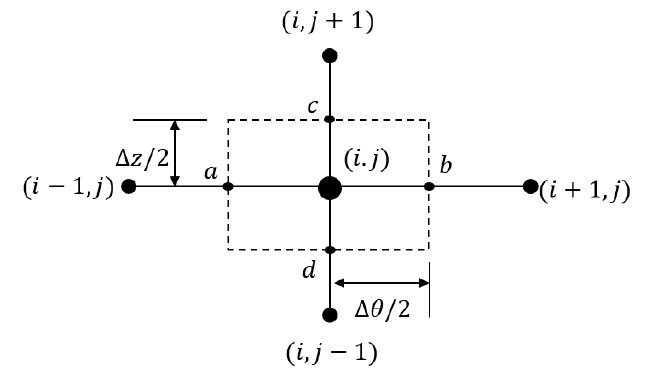
Figure 3. Part of solution domain.